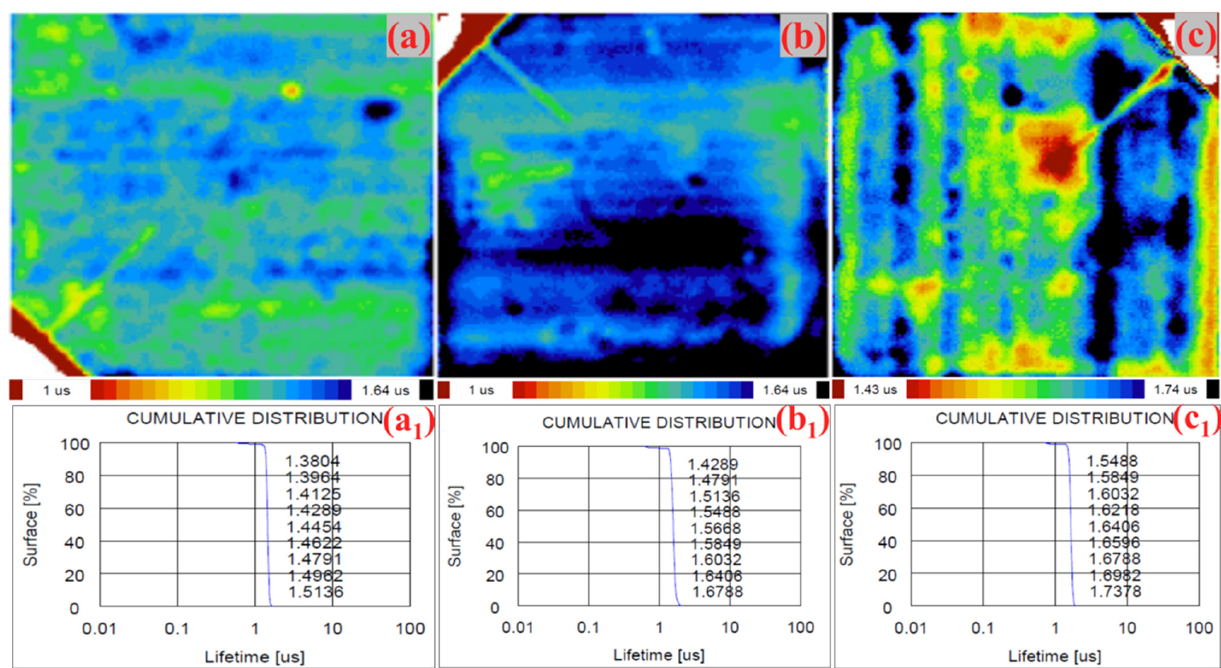
Figure 4. Analysis of lifetime surface mapping images and cumulative distribution of lifetime of the surface of the HfO 2 layer deposited at spinning rate rpm ( a , a 1 ) 1000 ( b , b 1 ) 2000 ( c , c 1 ) 3000 for c-Si solar cell.